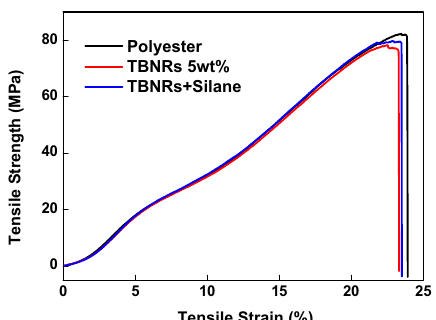
Fig. 7 Tensile stress–strain curve of untreated PET, PET treated with tungsten bronze nanorods (TBNRs), and PET treated with TBNRs and silane